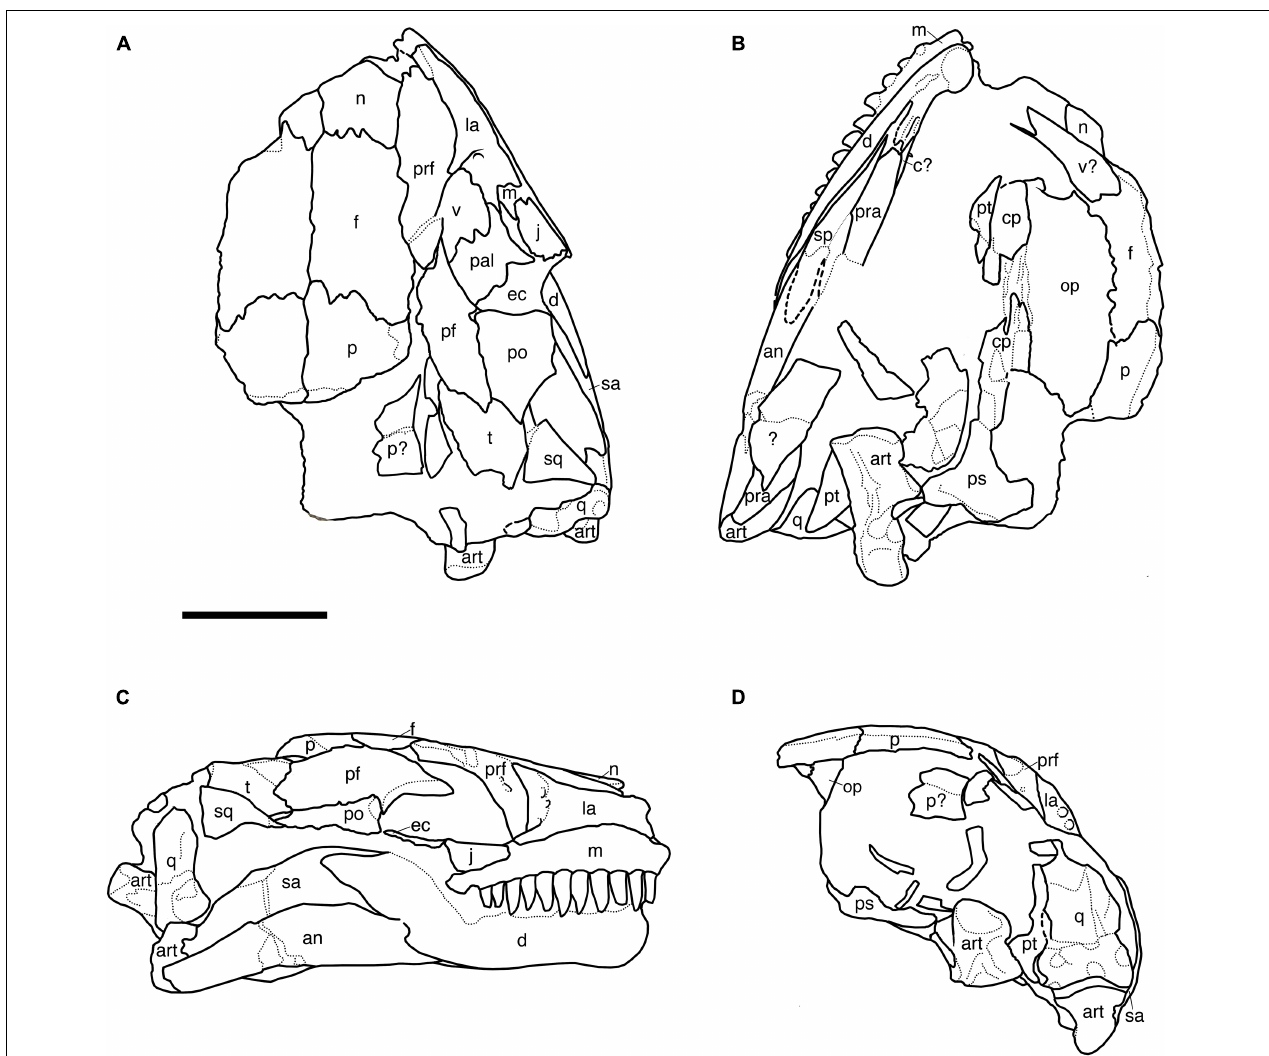
FIGURE 7 | Line drawings of the partial skull of Nannaroter mckinziei , ROMVP 86541. (A) Dorsal view, (B) ventral view, (C) right lateral view, and (D) occipital view. an, angular; art, articular; c, coronoid; cp, cultriform process; d, dentary; ec, ectopterygoid; f, frontal; j, jugal; la, lacrimal; m, maxilla; n, nasal; op, opisthotic; p, parietal; pf, postfrontal; po, postorbital; pra, prearticular; prf, prefrontal; ps, parasphenoid; q, quadrate; qj, quadratojugal; sa, surangular; sq, squamosal; t, tabular. Scale bar equals 5